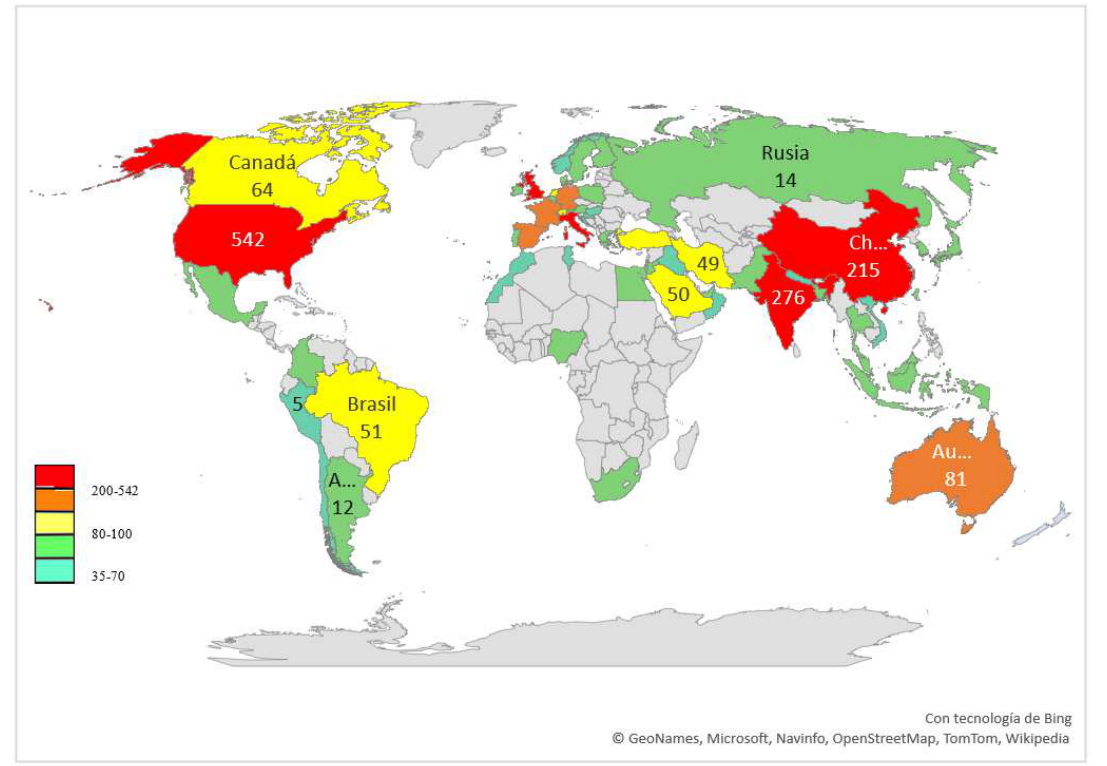
Figure 1. Geographical distribution of publications on eye-related COVID-19. Map color is coded where the world regions in red had the highest productivity, and those in green and blue the lowest productivity.